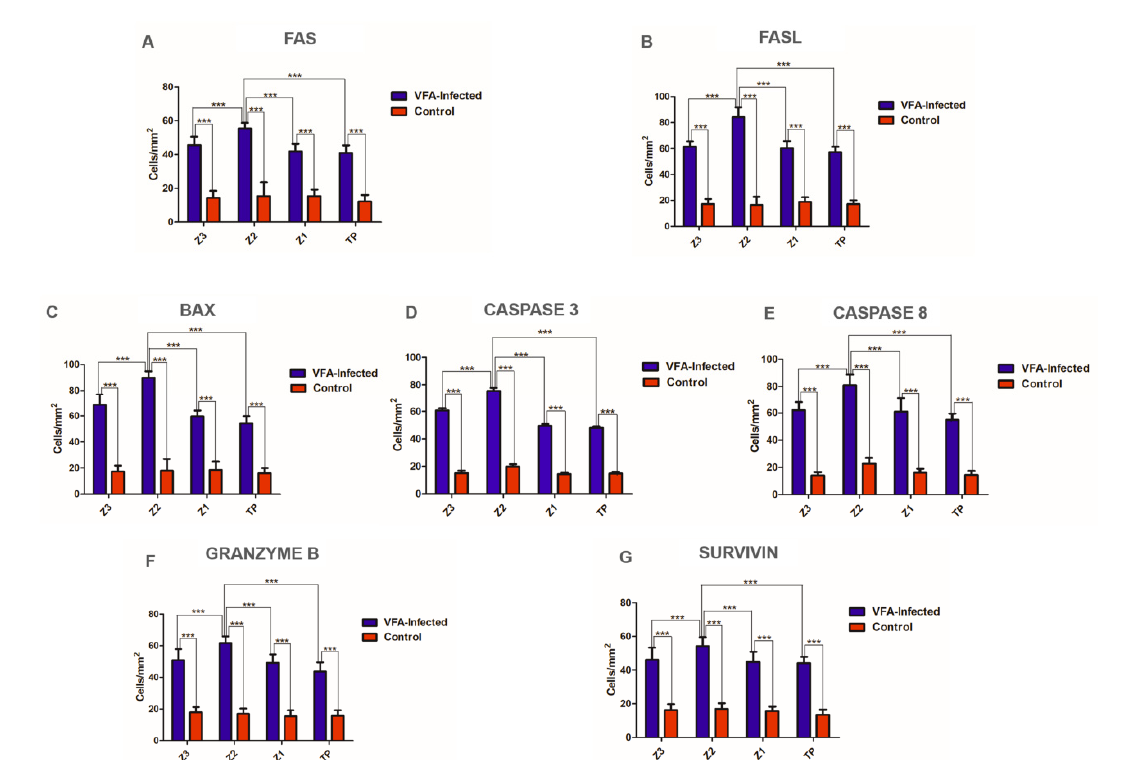
Figure 3. Quantitative analysis of immunohistochemical data positive for ( A ) FAS, ( B ) FASL, ( C ) BAX, ( D ) CASPASE 3, ( E ) CASPASE 8, ( F ) GRANZYME B, and (G) SURVIVIN in zones Z3, Z2, Z1, and PT in the hepatic parenchyma of fatal yellow fever cases (blue) and negative controls (red). Z3: centrolobular zone; Z2: midzonal zone; Z1: periportal zone; PT: portal tract; one-way ANOVA; *** p < 0.0001. Tukey’s post-hoc test; *** p < 0.0001.